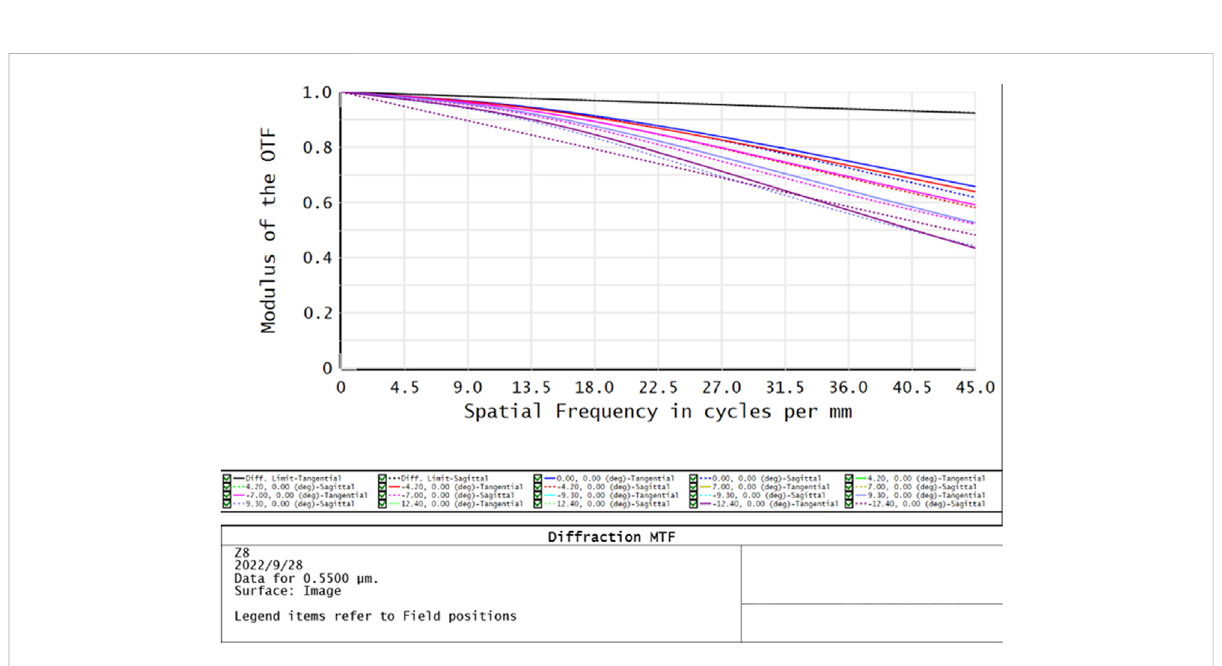
FIGURE 2 MTF curve of the whole system at the central